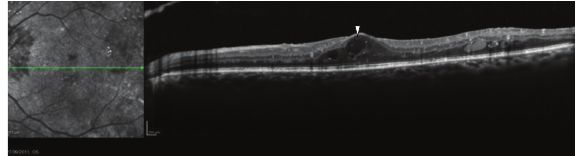
Figure 3: An OCT horizontal line scan of a 62-year-old man with diabetic retinopathy and macular edema-intraretinal cysts (white